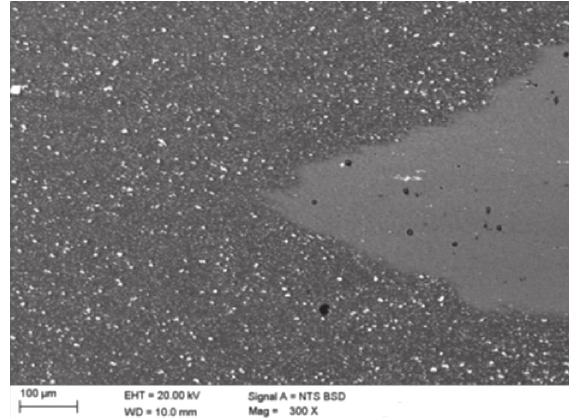
Figure 12: Micrograph for experiment no.12 at SZ interface (RS on the right-hand